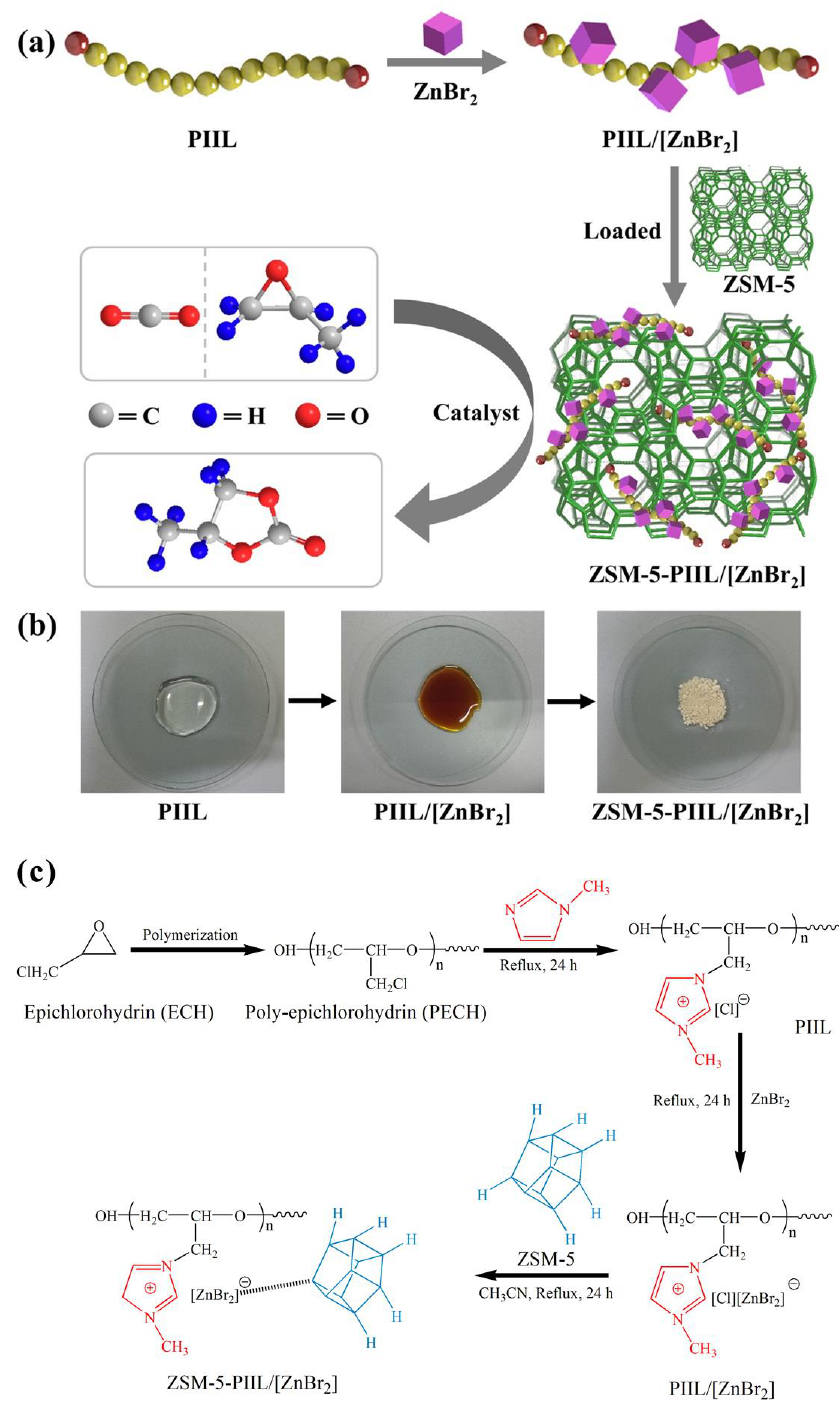
Figure 1. ( a ) The diagram for the preparation of immobilized catalysts for the synthesis of propylene carbonates from carbon dioxide; ( b ) the photos of the synthesized materials showing the color change and phase transition; and ( c ) the chemical structure of the catalyst and its synthesis process, taking ZSM-5-HO-[PECH-MIM]Cl/[ZnBr 2 ] as an example.